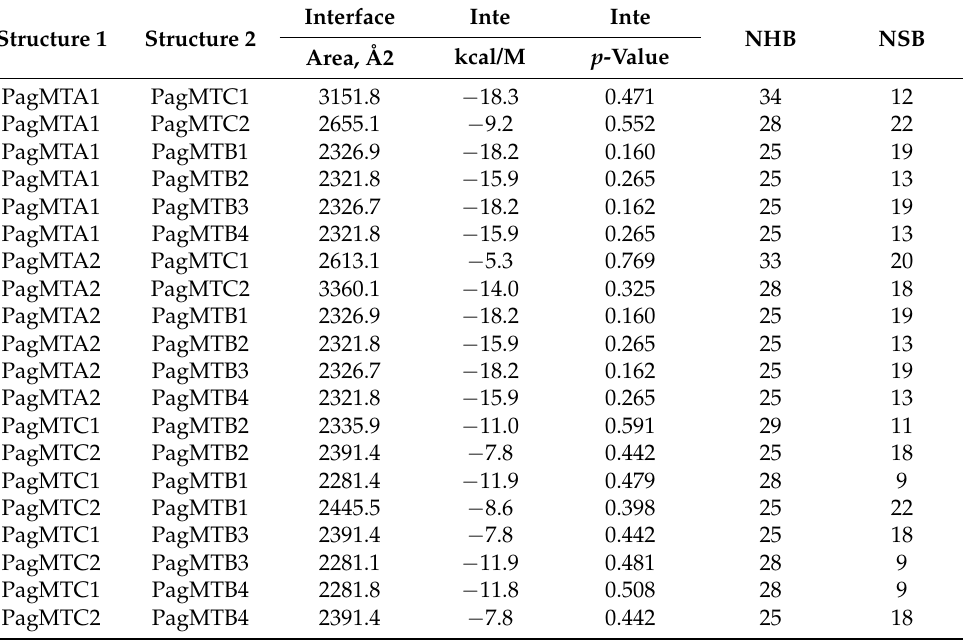
Table 3. Protein–protein docking of PagMTAs, PagMTBs and PagMTCs. NHB: number of potential hydrogen bonds. NSB: number of potential salt